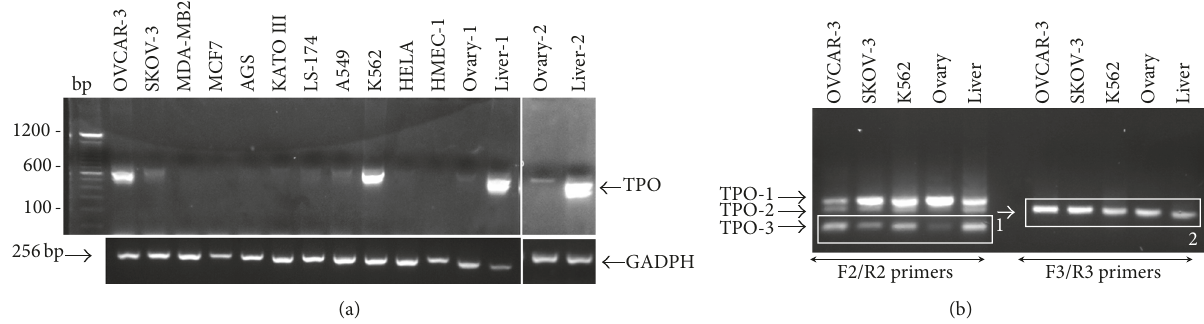
Figure3:TPOgeneexpressionbycelllines.(a)FirstPCRanalysisofTPOandGADPHgeneexpressedbyvariouscelllines,ovarian(OVCAR- 3 and SKOV-3), breast (MDA-MB231 and MCF7), gastric (AGS, KATO-III), intestinal (LS174T), lung (A549), leukemia (K562), cervical (HELA), and human microvascular endothelial (HMEC-1) cell lines. 2% agarose gel. Normal adult ovary (1 and 2) and liver (1 and 2) tissues served as control. (b) 2% agarose gel pattern of nested-PCR product of TPO: TPO-1 (full length), TPO-2 (12bp deletion), and TPO-3 (116bp deletion). Boxes (1, 2) represent bands chosen for